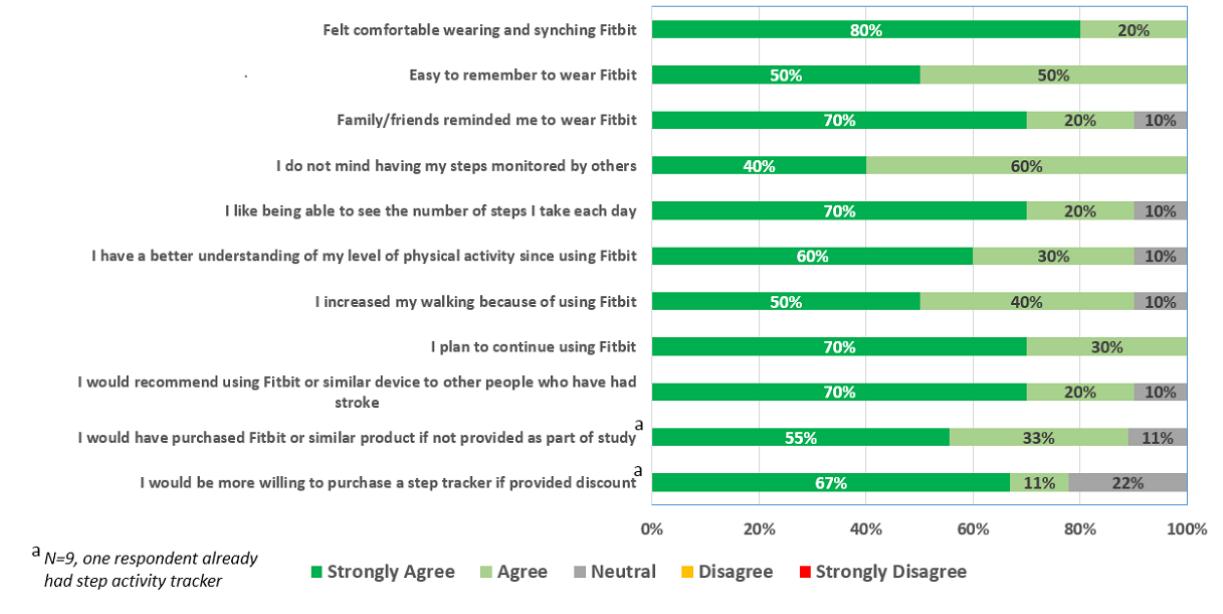
Figure 3. Participant experience survey responses